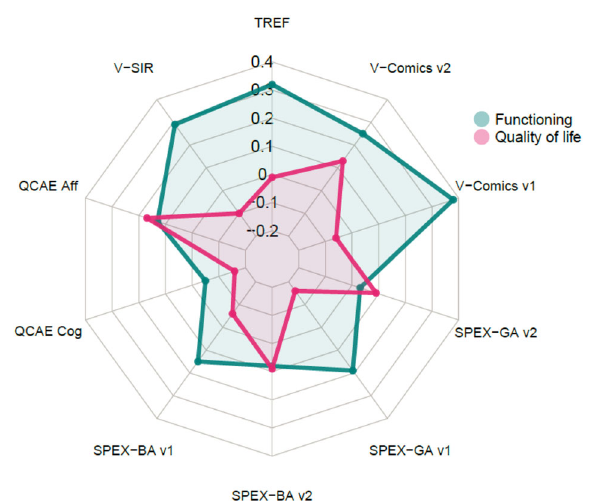
Fig. 1 ß standardized coef fi cients of simple cross-sectional regressions of functioning (PSP) and quality of life (S-QoL) on various social cognition variables at inclusion. TREF, Test de Reconnaissance des Émotions Faciales — Facial Emotion Recognition Test, V-Comics: Versailles Intention Attribution Task, SPEX-GA & BA: Social cognition, Perception, eXecutive functions — Belief & Goal Attribution sensitivities, QCAE Cog: Questionnaire of Cognitive and Affective, QCAE aff: Questionnaire of Cognitive and Affective Empathy — Affective empathy subscore Empathy — Cognitive empa- thy subscore, V-SIR: Versailles Situational Intention Reading. The signs of ß were reversed for V-SIR. was associated with better functioning (see Fig. 1, Supplementary Table 5). Signi fi cant associations with functioning were also found for all neurocognitive variables (0.2 ≤ ß ≤ 0.34, Supplementary Table 6) and clinical variables ( − 0.41 ≤ ß ≤ − 0.25, Supplementary Table 7). Hence, we further investigated the relationships between social cognitive variables and functioning, successively taking into account clinical variables and neurocognition. First, the TREF, V- SIR, and V-Comics remained signi fi cant predictors of functioning,